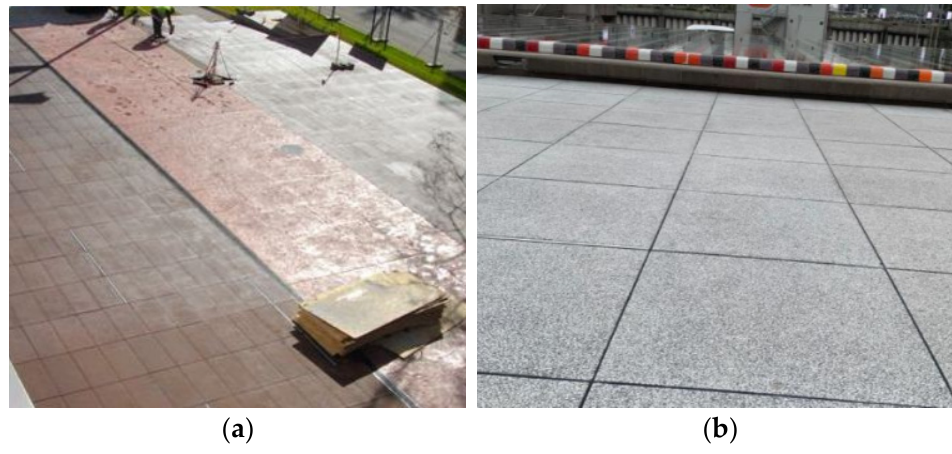
Figure 32. ( a ) GFRC tunnel panels [131]; ( b ) GFRC municipal sewerage panels [132]; ( c ) GFRC melioration system [133]; ( d ) GFRC ducts [134].